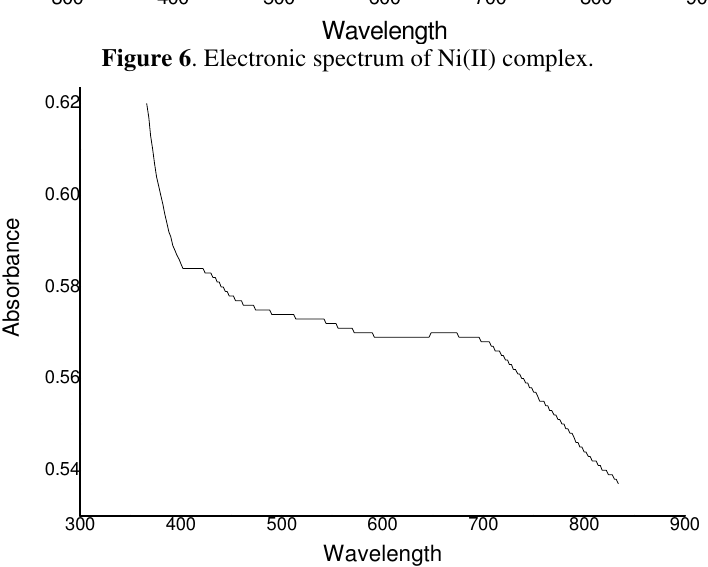
Figure 7 . Electronic spectrum of Cu(II)